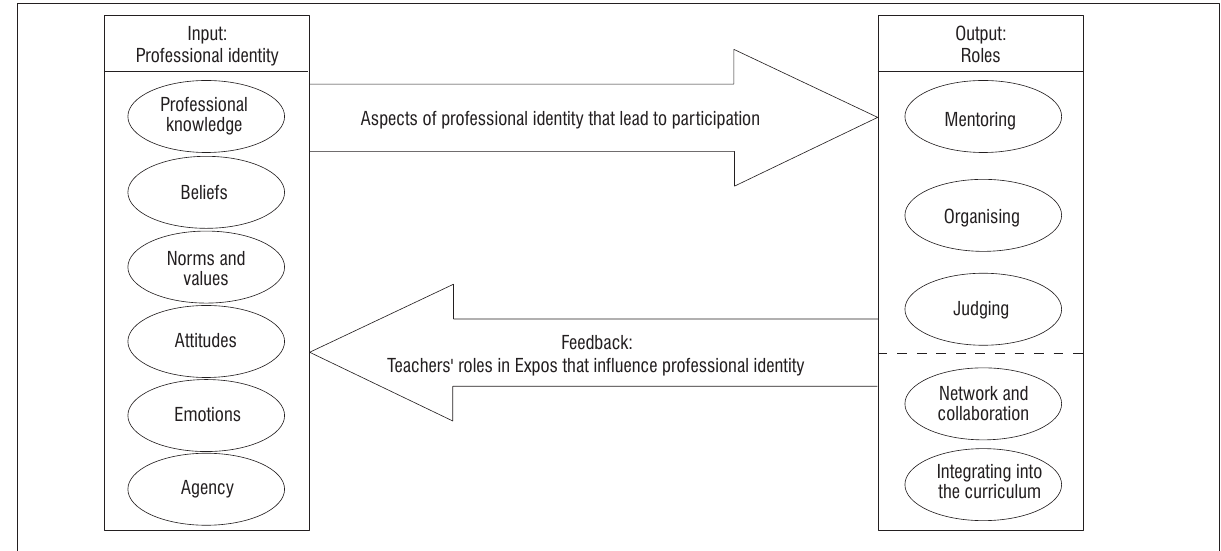
Figure 1: Conceptual framework of professional identity of teachers and their roles in science